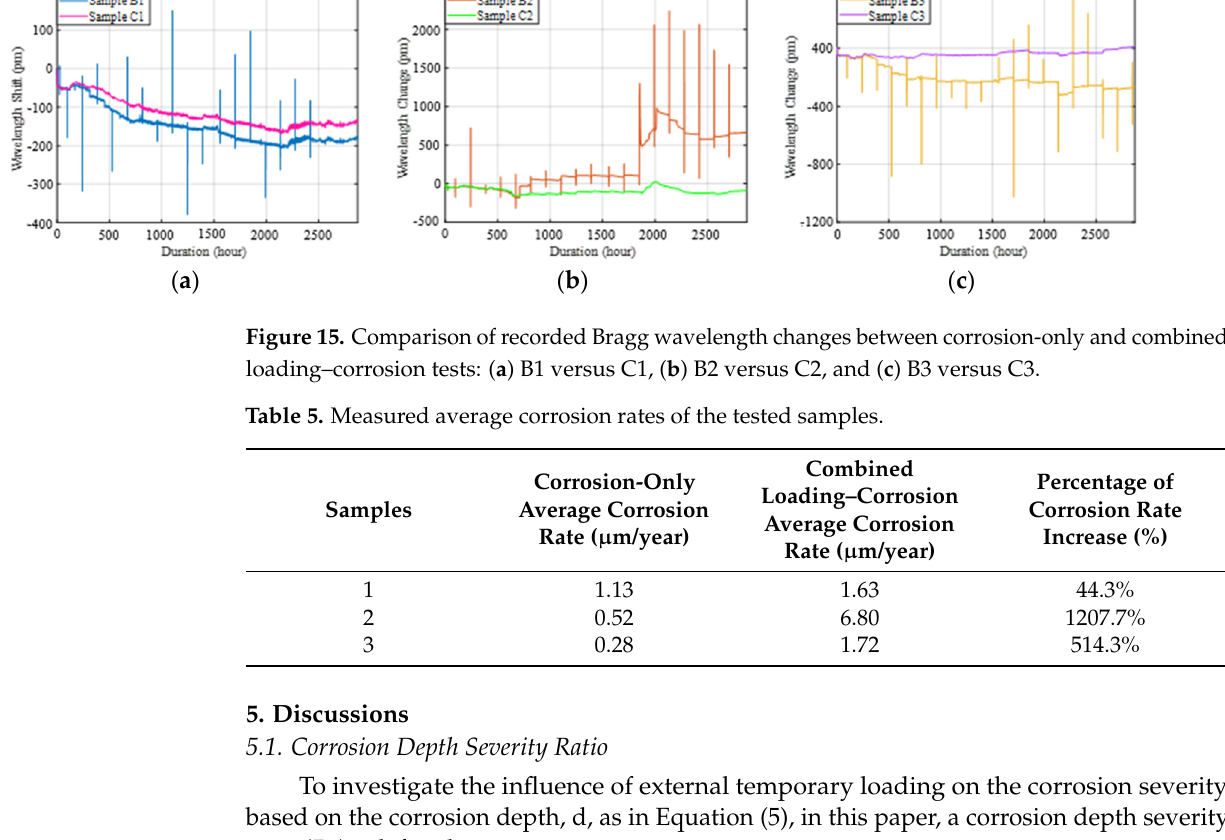
Figure 14. Visual inspections of the three tested samples under combined loading–corrosion tests at the end of the experiments: ( a ) B1, ( b ) B2, and ( c ) B3.